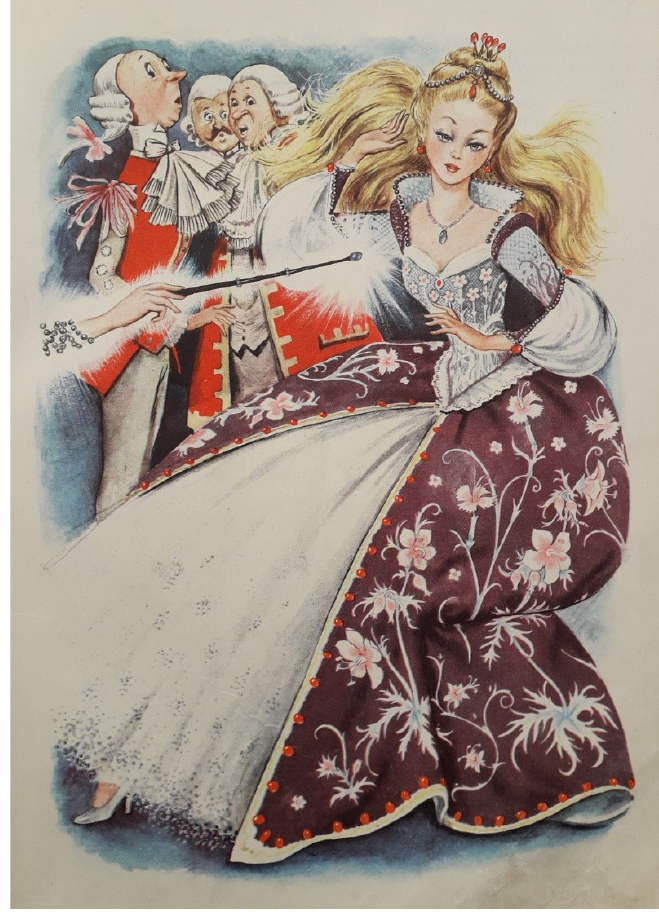
Figure 4. Illustration of Charles Perrault’s The Little Red Riding Hood and Other Fairy Tales (Cinderella), 1958. Illustrated by Gianni Benvenuti . Sofia: Narodna Mladezh.